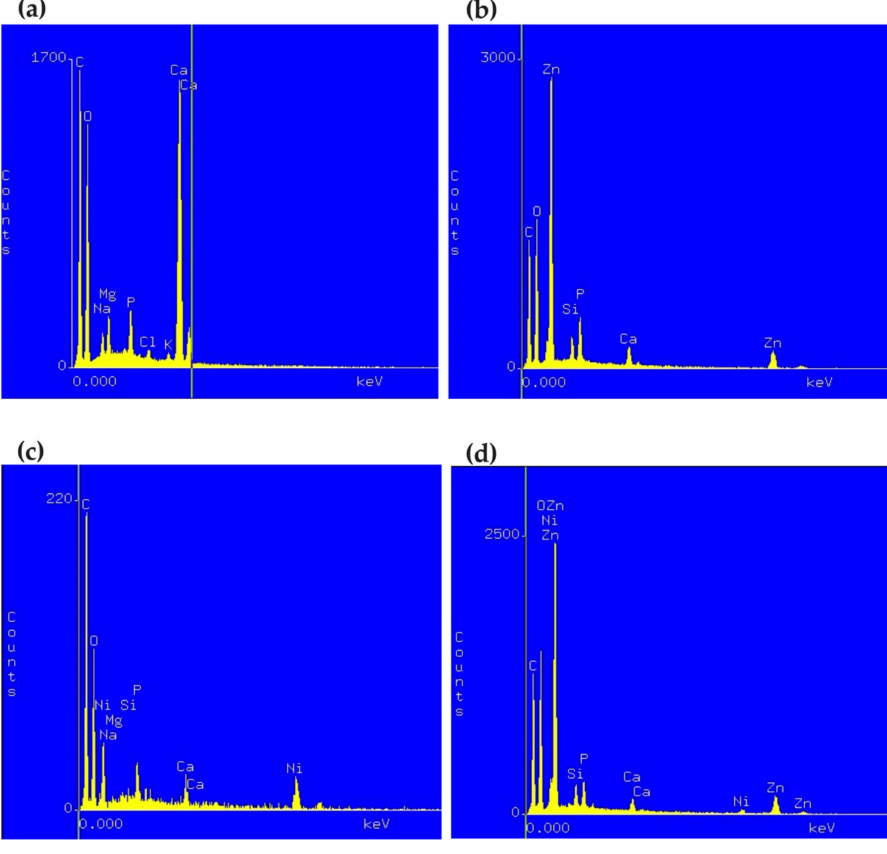
Figure 6. EDX spectra of ( a ) the native CS and the CS loaded with ( b ) Zn 2+ , ( c ) Ni 2+ , and ( d ) Zn 2+ +Ni 2+